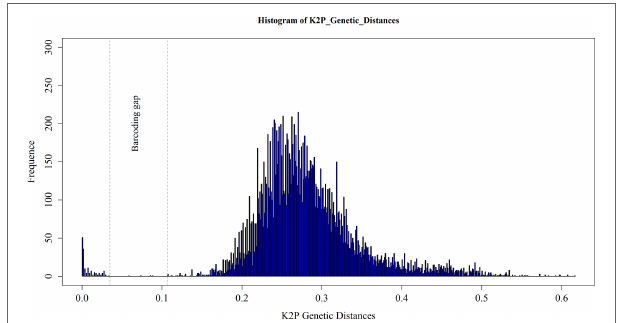
FIGURE 3 | Frequency distributions of intraspecific and interspecific pairwise genetic K2P distances based on all marine crustacean larvae sampled at the Zhongshan Islands. The area between dashed lines shows the “barcoding gap” between the intra- and interspecific distances.